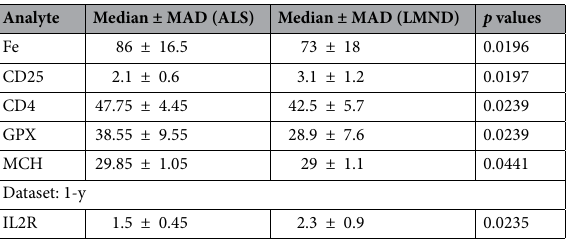
Table 2. List of significantly different blood analytes between ALS and LMND, and the related descriptive statistics (median and median absolute deviation,